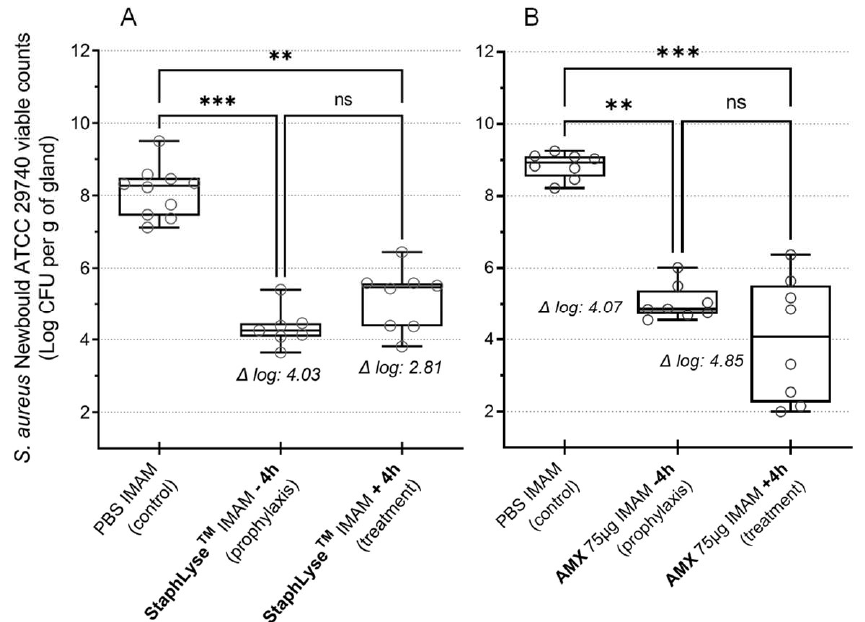
Figure 9. Effect of prophylactic administration of StaphLyse™ ( A ) or amoxicillin ( B ) in the S. aureus mouse mastitis model. S. aureus ATCC 29740 was inoculated IMAM, at a concentration of 100 CFU in a volume of 100 µ L, in the 2 fourth glands in lactating CD-1 mice separated from pups 1 h prior to infection. StaphLyse™ (10 8 PFU per gland) or amoxicillin (AMX, 75 µ g per gland) was administered via the IMAM route at either 4 h before infection ( − 4 h) or 4 h after infection (+4 h). Mammary glands were harvested 18 h after infection for determination of the bacterial load (CFU per gram of gland). Each dot on the graph represents the bacterial load for each gland, whereas whiskers show the minimum and maximum values. The horizontal bars within the boxes indicate the median value for each group. Log CFU differences between controls and tests are shown in italic. Statistical significance was evaluated by the Kruskal–Wallis comparison test followed by Dunn’s multiple-comparison tests (ns: not significant, ** p < 0.01, *** p < 0.001).